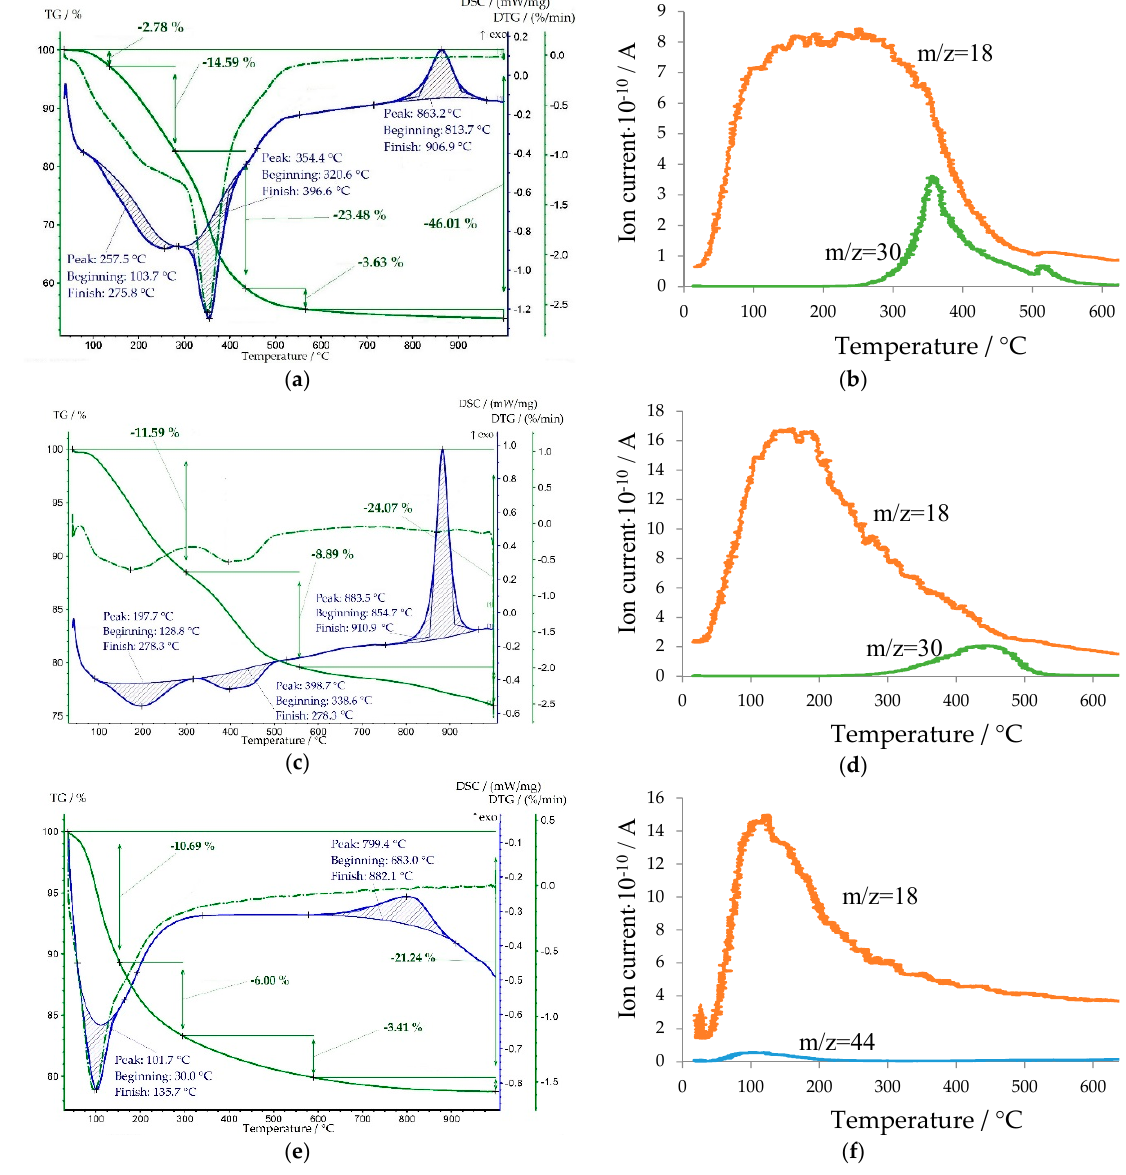
Figure 2. TG-DSC and MS analyses results of samples: S1 ( a , b ), S2 ( c , d ), S3 ( e , f ).